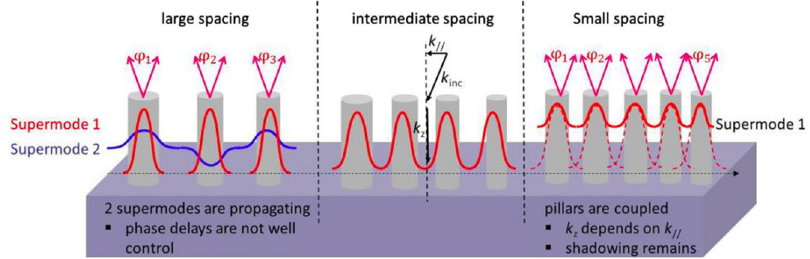
Figure 5: Critical choice of the unit spacing in waveguide-type structures. Left panel: large spacing. The phase delay that depends on both modes is hard to be accurately controlled. Central panel: intermediate spacing. The nanostructures are uncoupled and the phase delay is independent of k // . Right panel: small spacing. The phase sampling is fi ne but the nanostructures are coupled electromagnetically. Adapted with permission from ref. [68]. Copyright